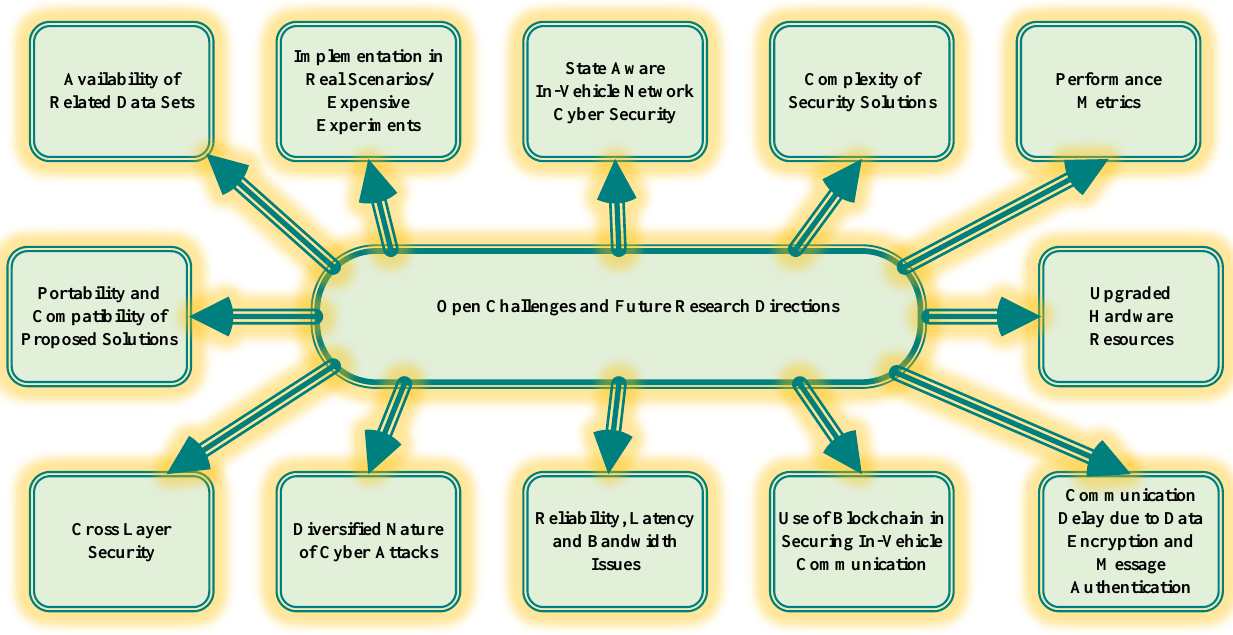
Figure 14. Open challenges for security of in-vehicle network.